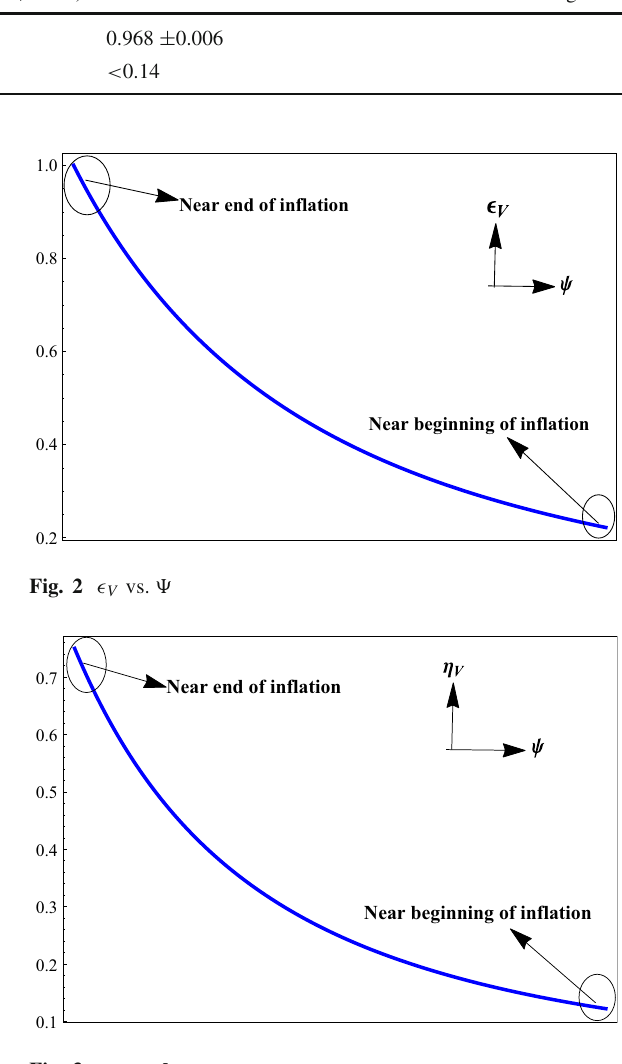
Figures2and3clearlydemonstratethataslongasinflation continues, the two slow roll parameters ( (cid:15) V and η V ) remain less than unity. This behavior of (cid:15) V and η V is expected from the slow roll approximation. Furthermore, the values of (cid:15) V and η V increase with the evolution of universe during the inflationary epoch and at the end of inflation, and (cid:15) V becomes 1, i.e. (cid:15) V ((cid:13) f ) =